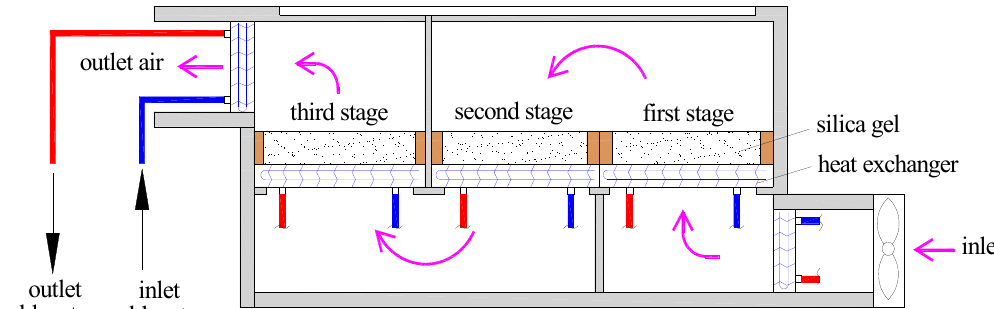
Figure 1. Schematic of the proposed system.